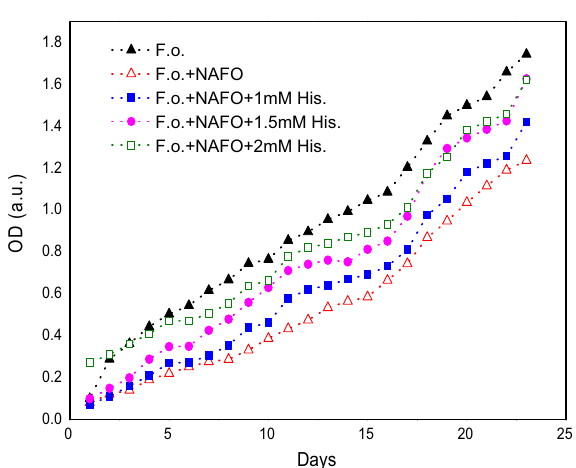
mediated toxicity. Figure 10 shows the involvement of histidine on the growth curve of F. oxysporum in the pres- ence of nanoparticles (Ni 0.5 Al 0.5 Fe 2 O 4 ) (0.05 mg/ml). Histidine (2 mM) almost completely inhibited the antifun- gal effect of nanoparticles Ni 0.5 Al 0.5 Fe 2 O 4 . Present study is conducted to study by testing whether the ROS pro- duced by the Ni 0.5 Al 0.5 Fe 2 O 4 nanoparticles. Figure 10 shows a dose dependent effect of histidine on the growth curve of F. oxysporum in the presence of Ni 0.5 Al 0.5 Fe 2 O 4 nanoparticles. Histidine (2.5 mM) almost completely inhibited the fungus and shows antifungal effect of Ni 0.5 Al 0.5 Fe 2 O 4 nanoparticles. The effect of histidine strongly indicates the role of ROS in the killing of F. oxysporum . Study clearly indicates the role and effect of histidine in the production of ROS, how it involve in the cell death by generating singlet oxygen and hydroxyl radical. We speculated in light of these results that the cytotoxic effect of Ni 0.5 Al 0.5 Fe 2 O 4 nanoparticles on F.oxysporum may be mediated through ROS. We can suggest the role of (Ni 0.5 Al 0.5 Fe 2 O 4 ) gives a promising results as a fungicidal activity and could be a novel family of future new generation fungicide. Our results suggest that nanomaterials which can induce ROS in water suspensions can also be used for fungal eradication, thus exhibiting another demonstration of the importance of nanoparticles. Effect of nanoparticles Ni Al Fe O on mycelial growth of pathogen (in vivo). After success- 0.5 0.5 2 4 ful inhibition of nanoparticles Ni 0.5 Al 0.5 Fe 2 O 4 under in vitro condition different concentration of nanoparticles were further evaluated for their efficacy in pots in polyhouse conditions. Results indicated that all concentra- tions of nanoparticles is effective in reduction of the disease incidence of dry rot of ginger (Table 4). Minimum occurrence of disease of dry rot (28.22%) was recorded at (0.5 mg/ml) 500 ppm concentration of Ni 0.5 Al 0.5 Fe 2 O 4 nanoparticles. Similarly, low disease incidence (39.08%) was recorded when we used (0.4 mg/ml) 400 ppm con-